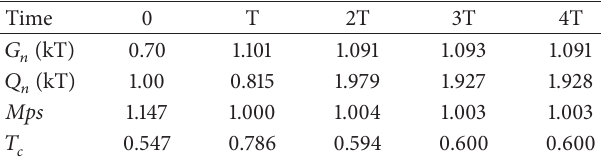
Table 1: Internal values of each tuning interval.